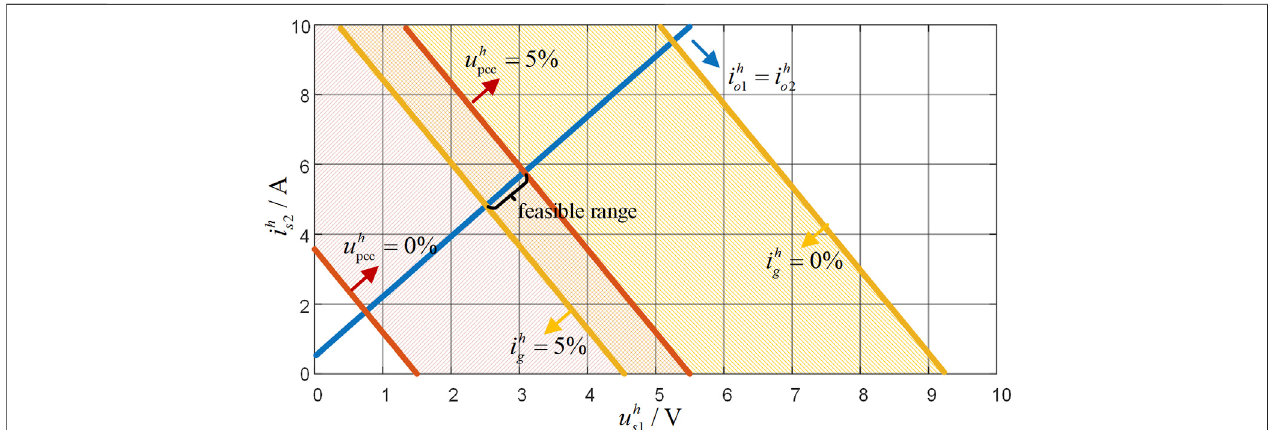
FIGURE 4 | Feasible ranges for the test